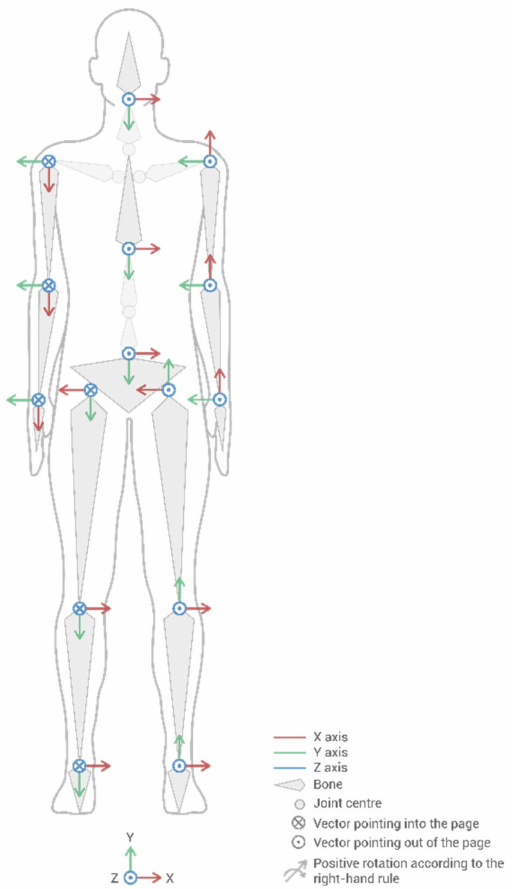
Figure 2. Human model in a neutral position. Sign convention is established to interpret the bone rotation directions according to the right-hand rule [35].